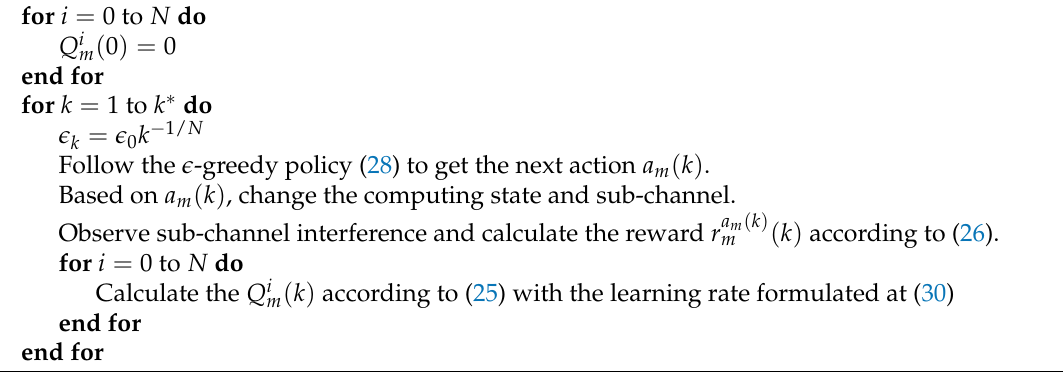
Algorithm 1 Distributed Q-learning for device m with (cid:101) -greedy learning